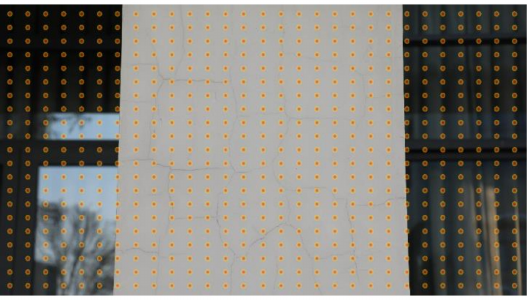
Figure 4. Reference anchor layout.